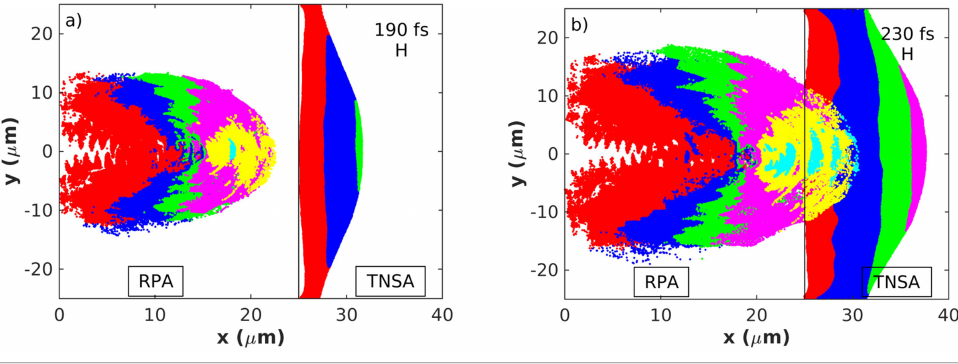
Figure 2. Proton energy layers for hydrogen target: ( a ) at 190 fs ( b ) at 230 fs from the beginning of laser–target interaction. The initial position of the target is between 0 µ m and 25 µ m (denoted by the black line). Republished with permission of IOP Publishing, Ltd., from [23], permission conveyed through Copyright Clearance Center,